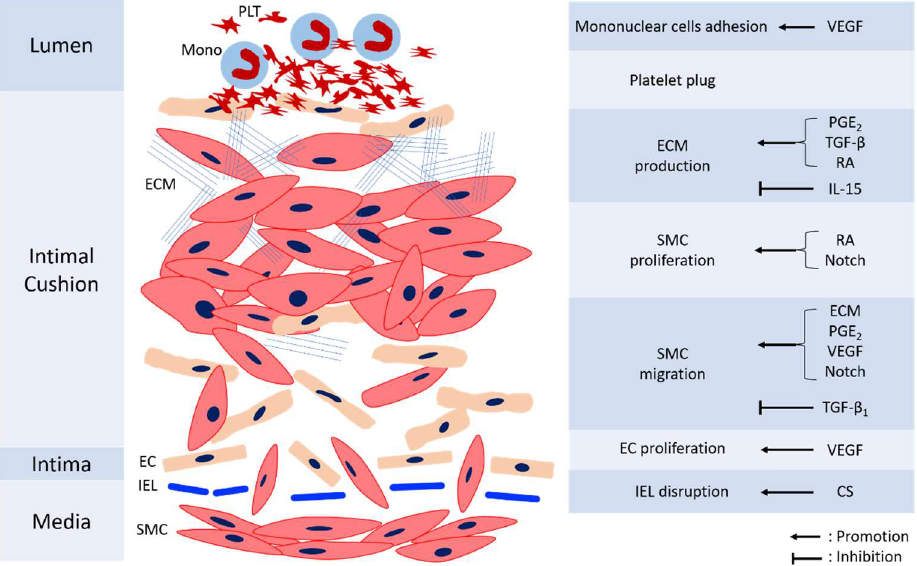
Figure 2. The diagram of anatomical closure of the ductus arteriosus. CS: chondroitin sulfate, EC: endothelial cells, ECM: extracellular matrix, IEL: internal elastic laminae, IL-15: Interleukin-15, Mono: monocyte, PDGF: platelet-derived growth factor, PGE 2 : prostaglandin E 2 , PLT: platelet, RA: retinoic acid, SMC: smooth muscle cells, TGF- β : transforming growth factor- β , VEGF: vascular endothelial growth factor. Table 2. Factors mediating anatomical closure of the ductus arteriosus.